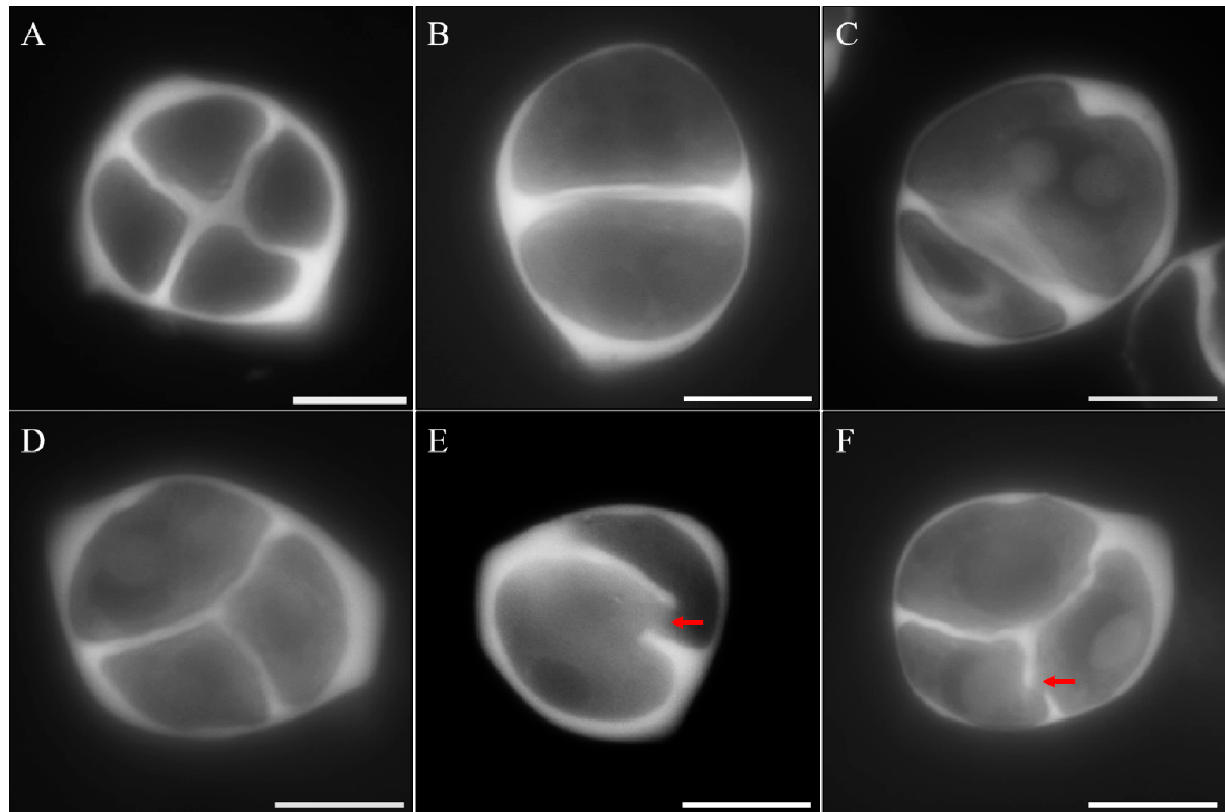
Figure 4. Meiotic cell formation is defective in mmr1 . ( A ) Tetrad with a complete meiotic cell wall in the wild-type. ( B – F ) Balanced dyad ( B ), unbalanced dyads ( C , E ), and triads ( D and F ) in mmr1 . Red arrows indicate the interruptions in meiotic cell walls of mmr1 . Scale bars = 10 µm.